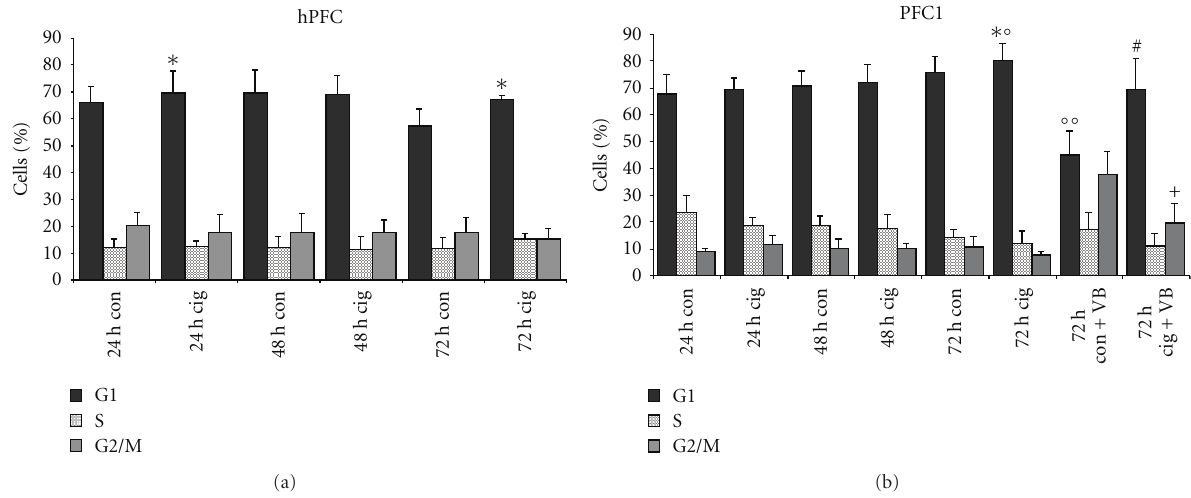
Figure 4: Cell cycle analysis. (a) Cell cycle analysis in hPFC cells after 24 h, 48, and 72 h of treatment with 3.3 μ M ciglitazone. The rise in G1 phase cells (black) was significant after 24h ( ∗ ) and 72 h ( ∗ ) compared to concomitant control values. S phase is depicted in hatched columns, and G2/M phase is depicted in grey, n ≥ 3. (b) Cell cycle analysis in PFC1 cells shows a steady rise in G1 phase cells over the time of culture, no matter if treated or not. At 72 h of ciglitazone treatment, the di ff erence compared to controls was significant ( ∗ ), as well as compared to 48h of treatment ( n ≥ 3). Vinblastine- (VB-) treatment showed a significantly reduced number of G1 cells compared to 72h untreated controls ( ◦◦ ) and 72 h ciglitazone treatment ( ◦ ), and a high level of G2/M phase cells. These e ff ects were diminished by ciglitazone: G1 phase cell numbers were not significantly di ff erent from 72h ciglitazone only ( # ), and G2/M phase accumulation was significantly reduced ( +